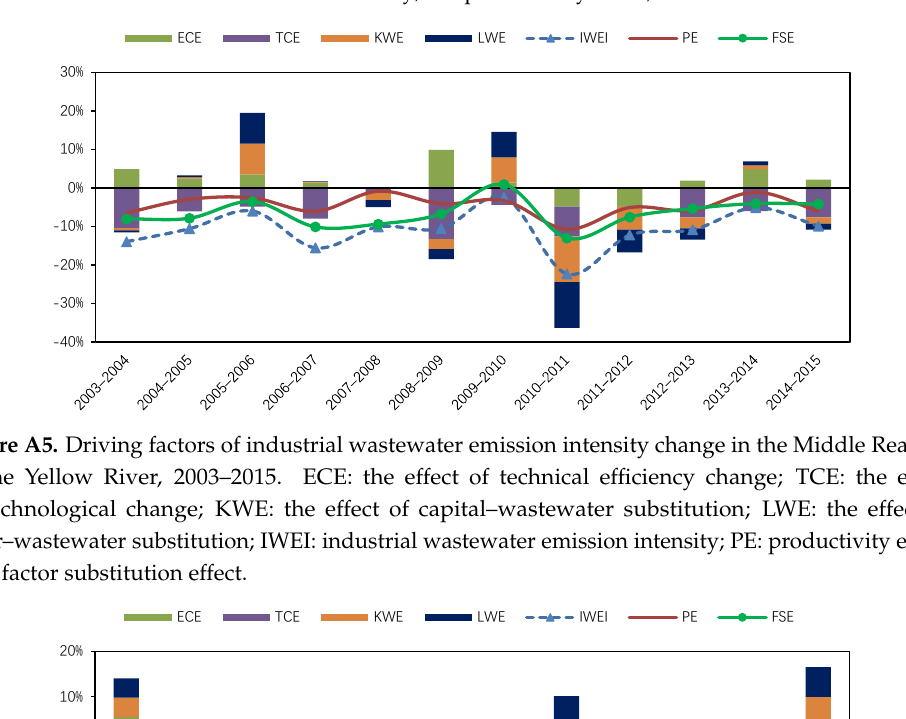
Figure A4. Driving factors of industrial wastewater emission intensity change in the Southern Coastal Area, 2003–2015. ECE: the effect of technical efficiency change; TCE: the effect of technological change; KWE: the effect of capital–wastewater substitution; LWE: the effect of labor–wastewater substitution; IWEI: industrial wastewater emission intensity; PE: productivity effect; FSE: factor substitution effect.